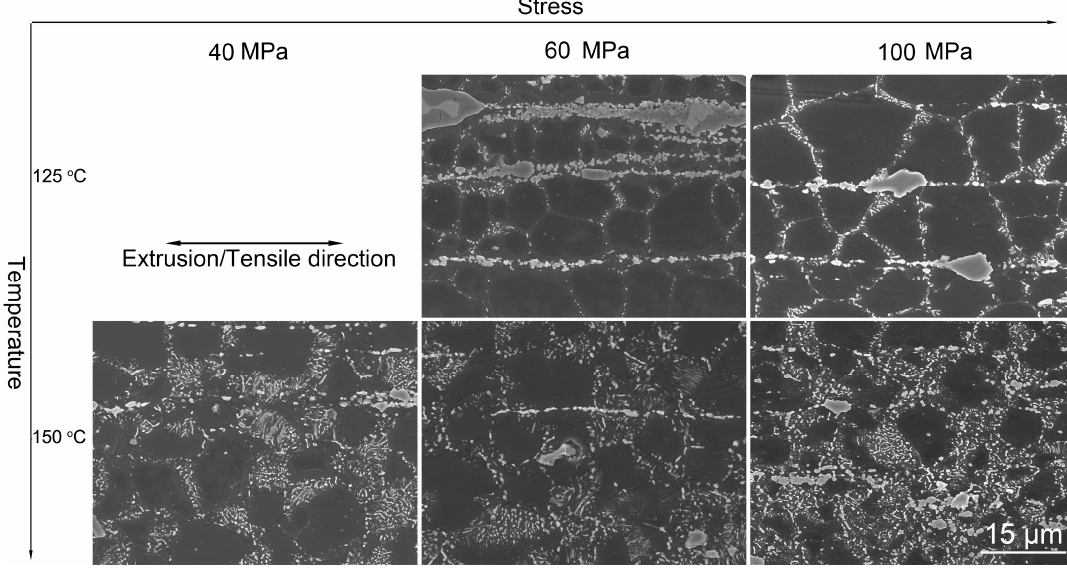
Figure 9. The typical SEM microstructures of the crept samples at temperature of 125–150 °C, under a stress of 40–100 MPa after 50 h.